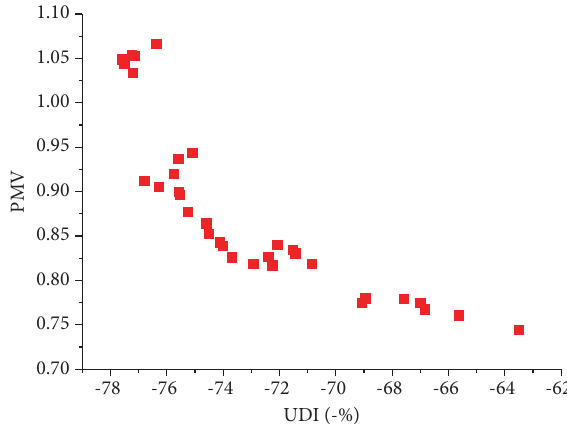
Figure 10: UDI and PMV performance of nondominated solutions in the 51st